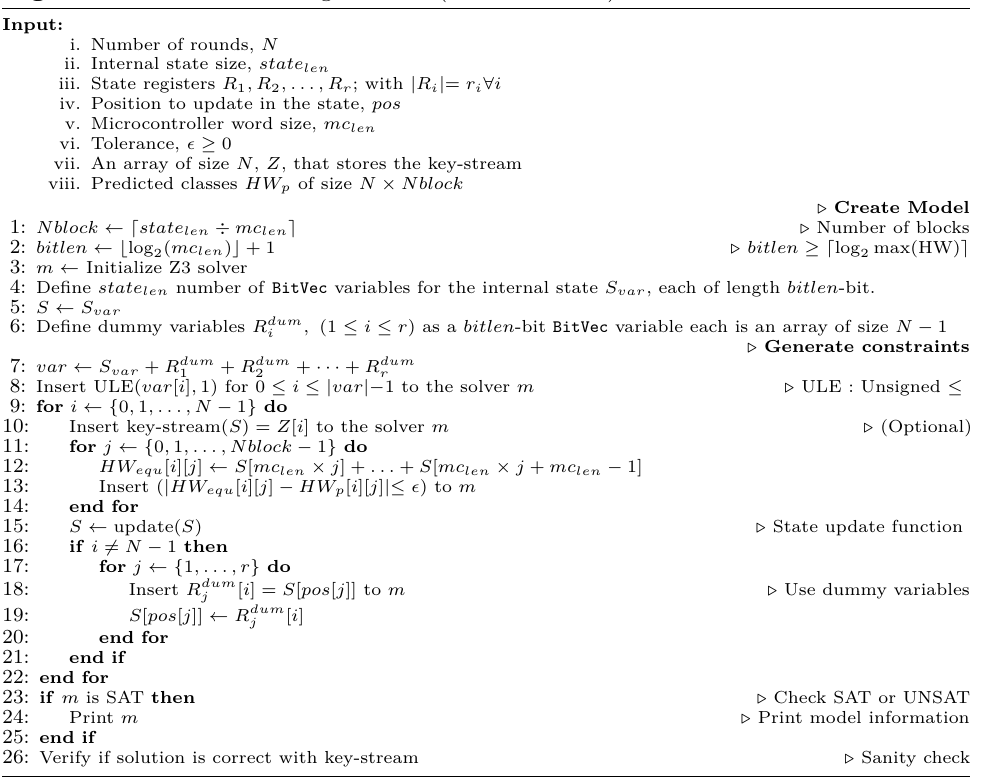
Algorithm 1 SMT modelling for SCA (from HW